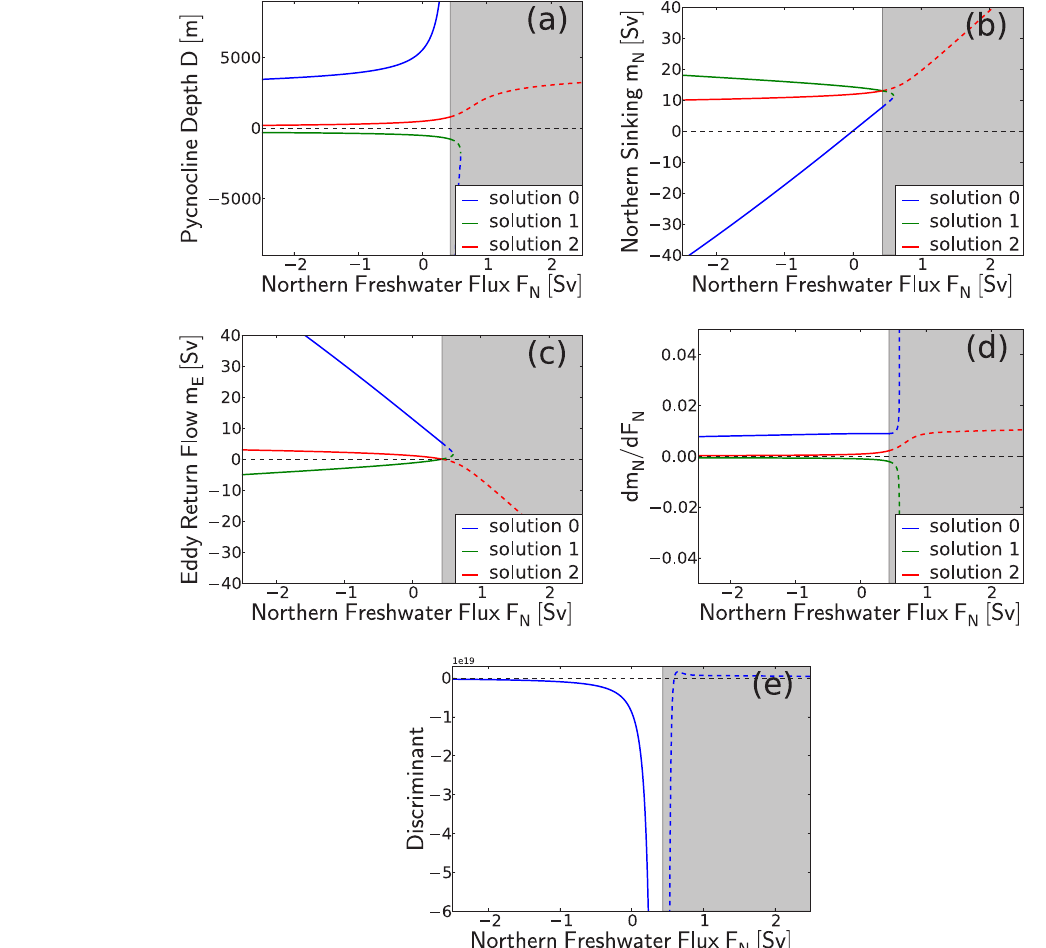
Figure 5. In steady state only one physical solution of governing equation for the wind-driven case exists. There are three real solutions before the circulation breaks down ( a , white area) because the discriminant is negative (e) . The physical branch is solution 2 (red line). The threshold (grey shaded area) is reached when the eddy return flow becomes negative ( c , red line) and the discriminant of the governing equation has a negative pole (e) . The zero crossing of the discriminant, which was in the parent model (Fürst and Levermann, 2012) the indicator for a cessation of the circulation, does not appear within the range applicability of our model. Within that range the northern sinking always increases ( b , red line) and its derivative is positive ( d , red